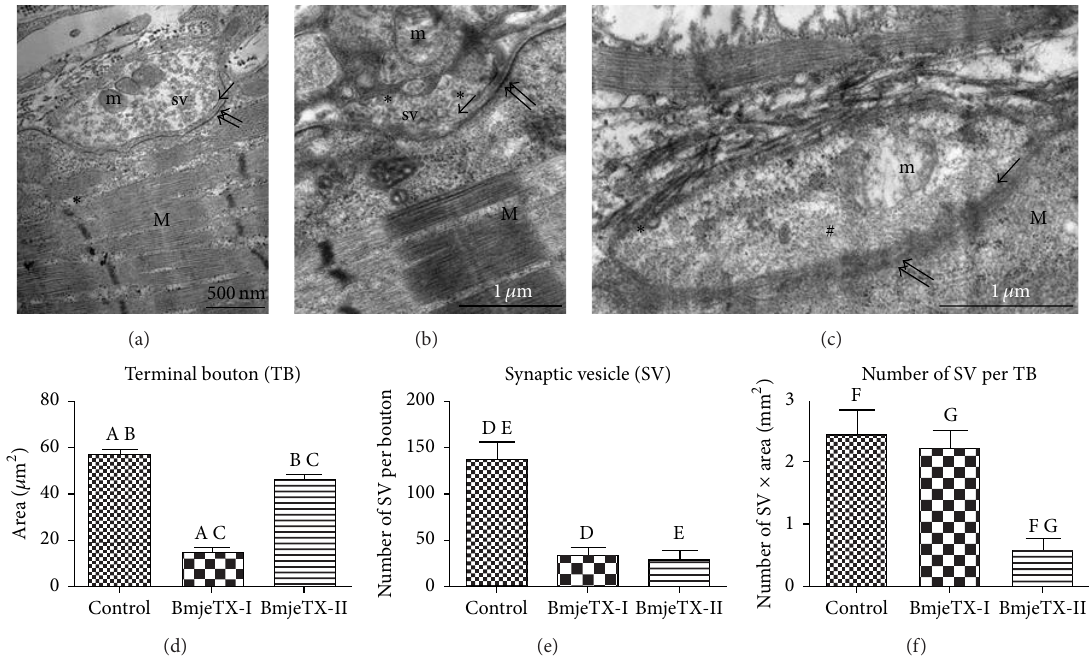
Figure 5: Electron micrographs of neuromuscular junction (NMJ) and synaptic morphometry of control (a), BmjeTX-I-treated (b), and BmjeTX-II-treated (c) chick biventer cervicis preparations. (a) Observe the bouton filled with synaptic vesicles (sv), intact mitochondria (m), and presynaptic membrane (arrow) associated with an unfolded but highly contrasted postsynaptic membrane due to the presence of acetylcholine receptors (double arrow). (b, c) Distorted terminal button, undefined axolemma (arrow), reduction of synaptic vesicles (#), and swollen mitochondria are present in the terminals; M: muscle fibre. (d)–(f) Graphical demonstration of terminal bouton area (d), mean number of synaptic vesicles per bouton (e), and relative number of synaptic vesicles per terminal bouton area (f) for control, BmjeTX-I, and BmjeTX-II groups. The bars with same uppercase letters indicate that there was significant difference ( A , C , D , E 𝑝 < 0.0001 ; B , F 𝑝 < 0.001 ; G 𝑝 < 0.05 ); data are mean ± SD one-way ANOVA plus Bonferroni posttest ( 𝑛 = 4 per